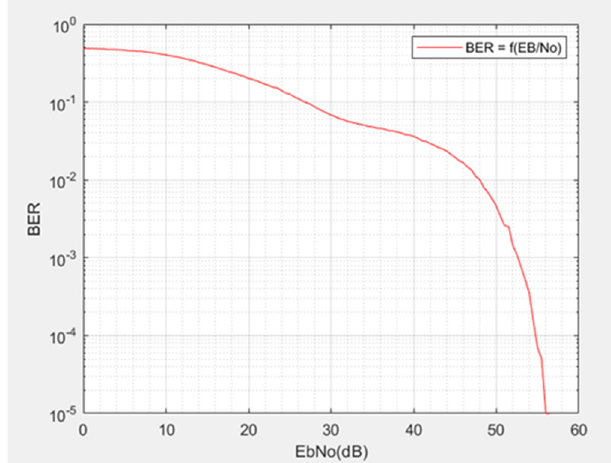
Figure 12. BER as a function of signal to noise ratio.